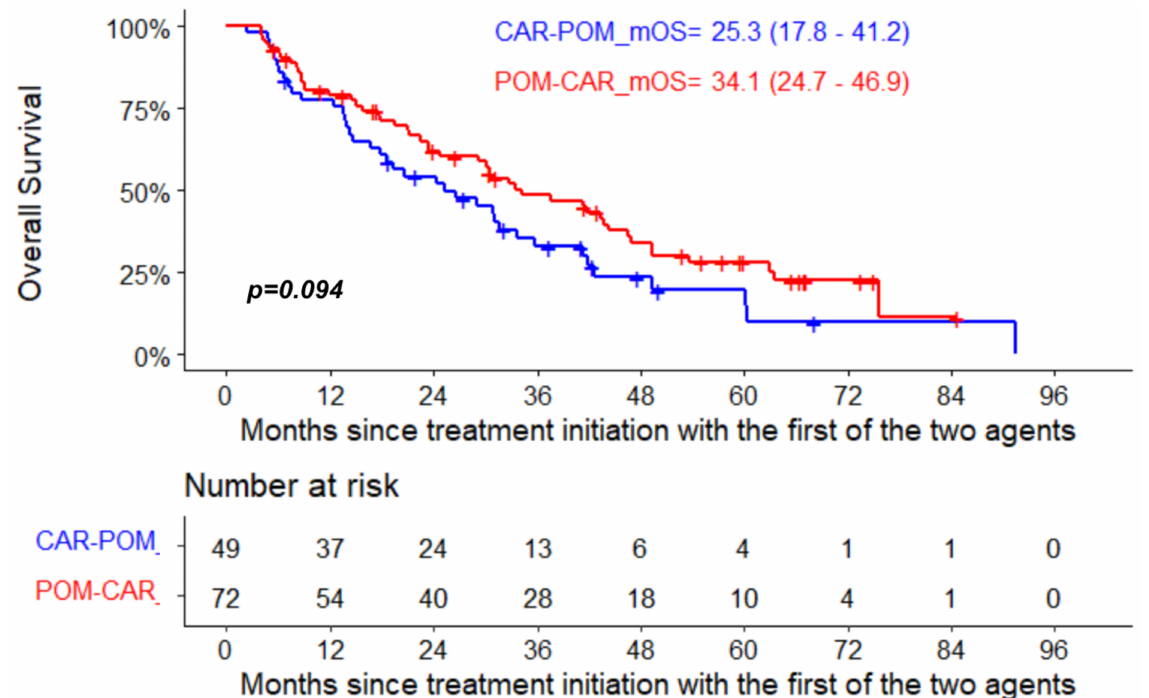
Figure 2. Landmark OS analysis from treatment initiation with the first of the two agents in the two